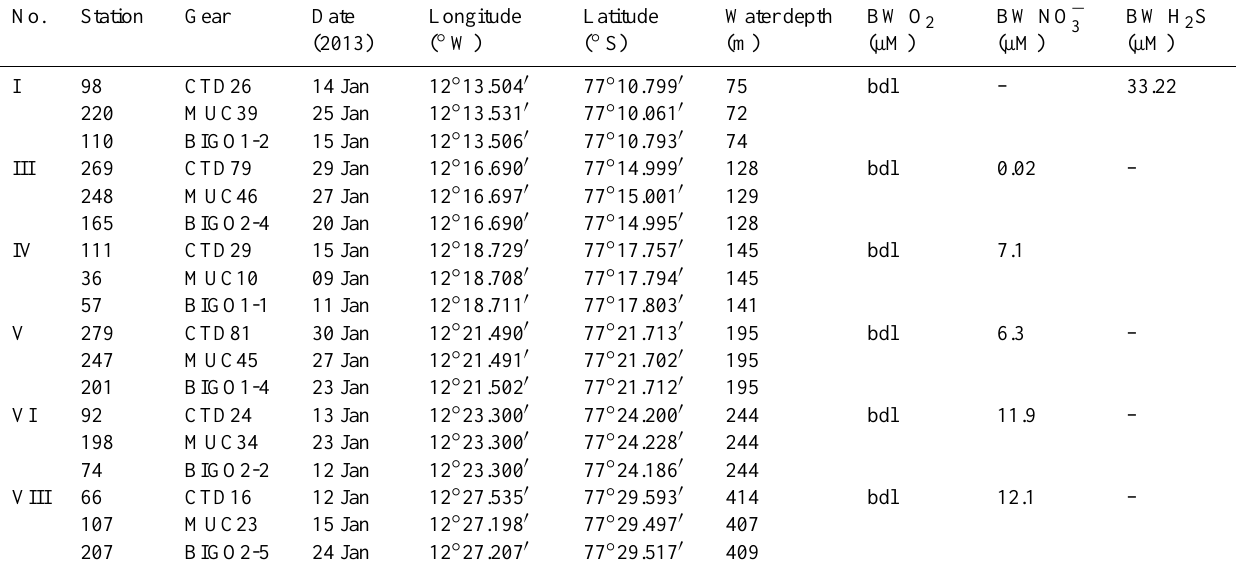
Table 1. Station list for the sites of the benthic lander (BIGO), multi-corer (MUC), and CTD deployments including the bottom water ) , and sulfide (H 2 S) in µM. The station numbers are according to Dale et al. (2015). bdl = below concentrations of oxygen (O 2 ) , nitrate (NO − 3 detection limit